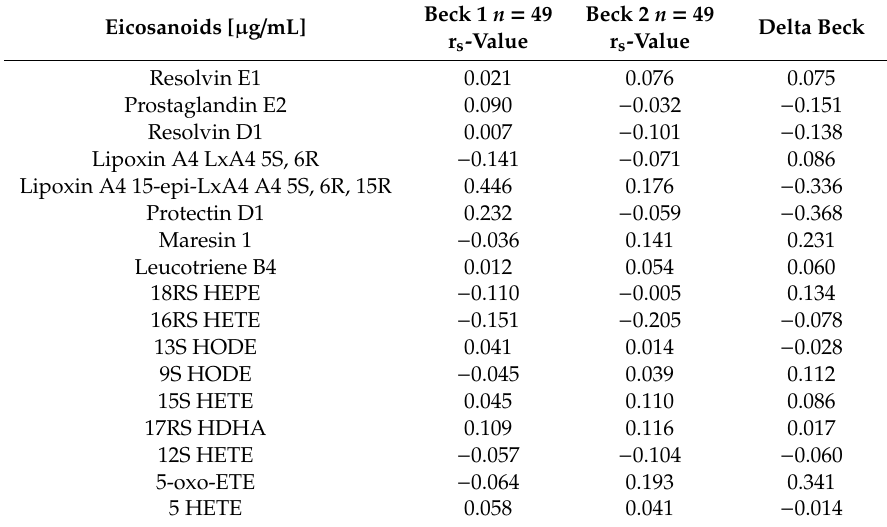
Table 4. The association between inflammation mediators and BDI-II score obtained on 7th day (Beck 1) and in follow-up after 6 months (Beck 2), and delta values. Eicosanoids [ µ g / mL]